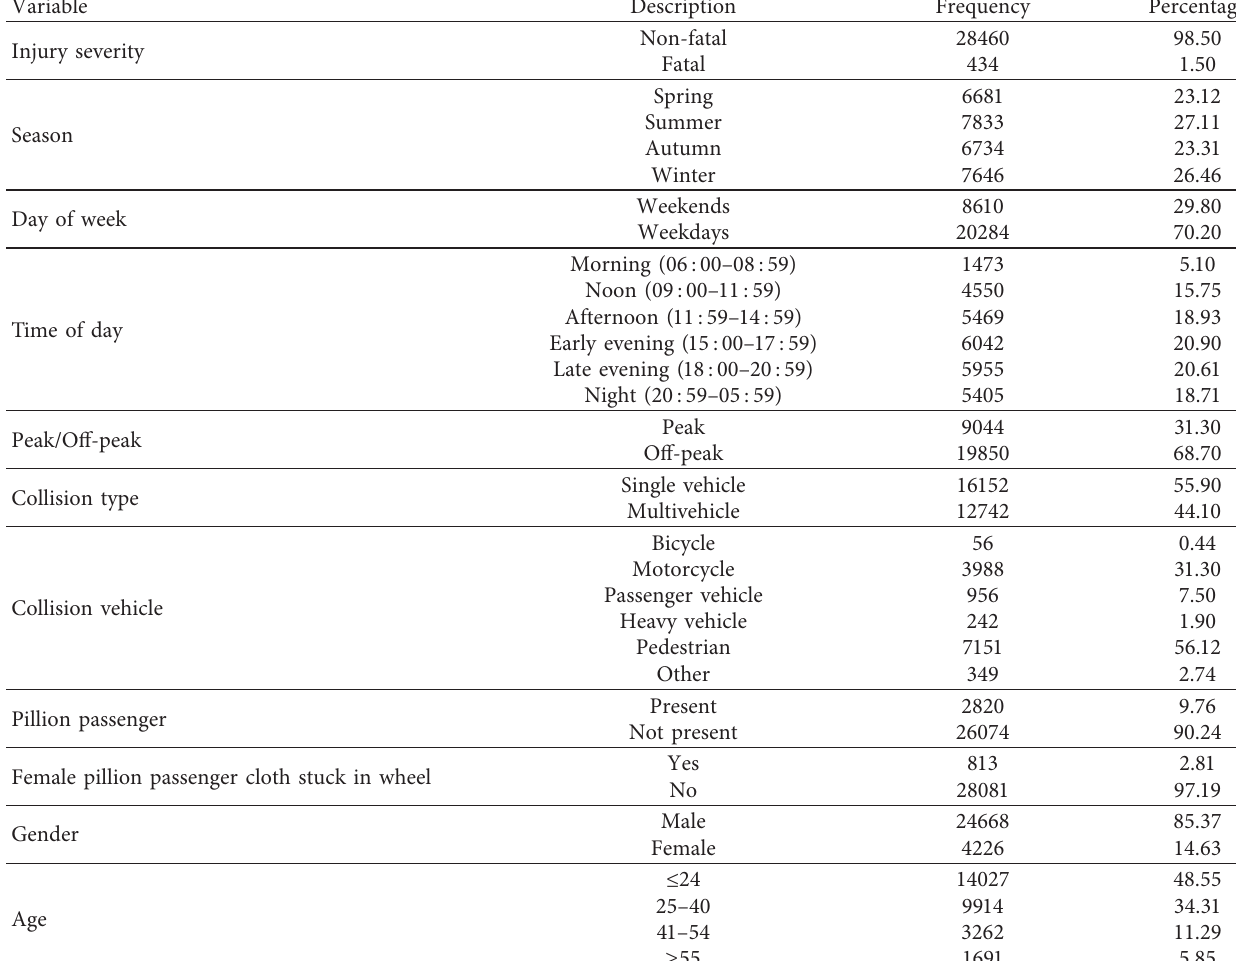
Table 1: Descriptive statistics of